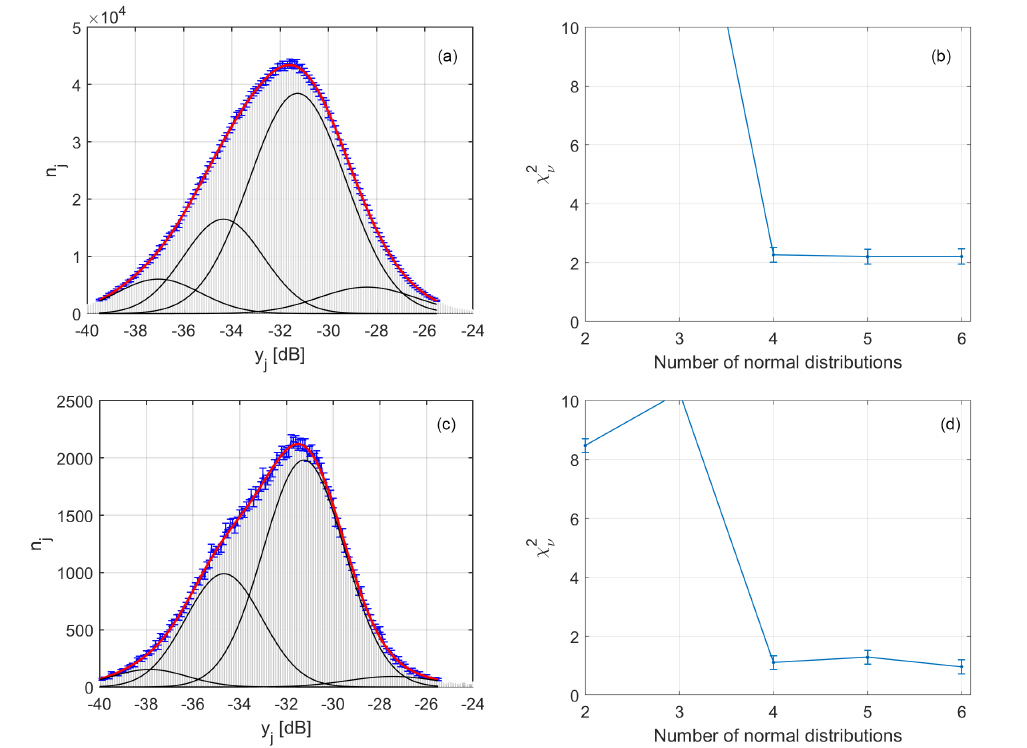
Figure 15. Comparison of Gaussian curve fitting to histogram of backscatter under two levels of averaging; limited averaging (top), heavier averaging (bottom); indicated in plots are Gaussian curve fitting ( a , c ), and chi-square test statistics ( b , d ). Fitting was done on grazing angle 26 degrees